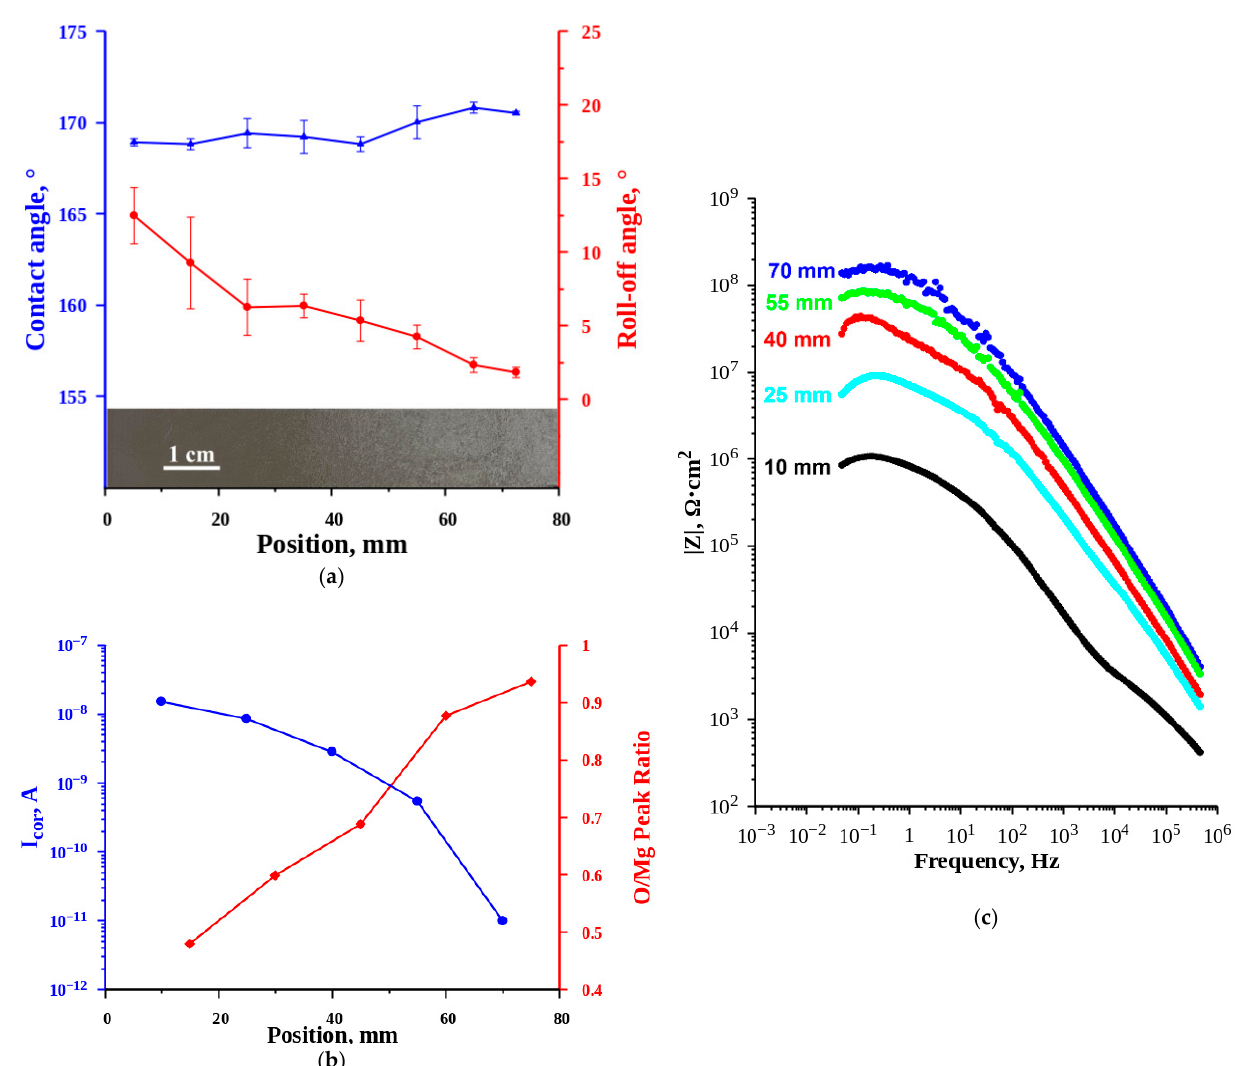
Figure 5. Properties of the gradient sample. ( a ) Contact (blue triangles) and roll-off (red circles) angle as functions of position on the sample, measured from the place where laser processing began. Error bars indicate standard deviations for at least five independent measurements. Inset shows the image of the gradient sample; the laser raster scanning started from the left end, which appears darker, and proceeded to the right. ( b ) Variations of corrosion current (I cor , blue circles) and the ratio of Oxygen to Magnesium peak heights (red rhombi) in EDX spectra (presented in Figure 2) along the sample. ( c ) The impedance modulus spectra for different locations on the sample.